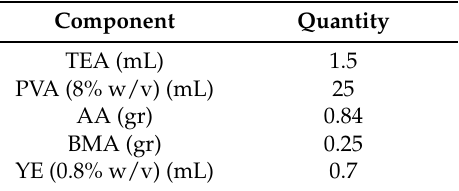
Table 1. Composition of the liquid solution for PVA/AA photopolymer.